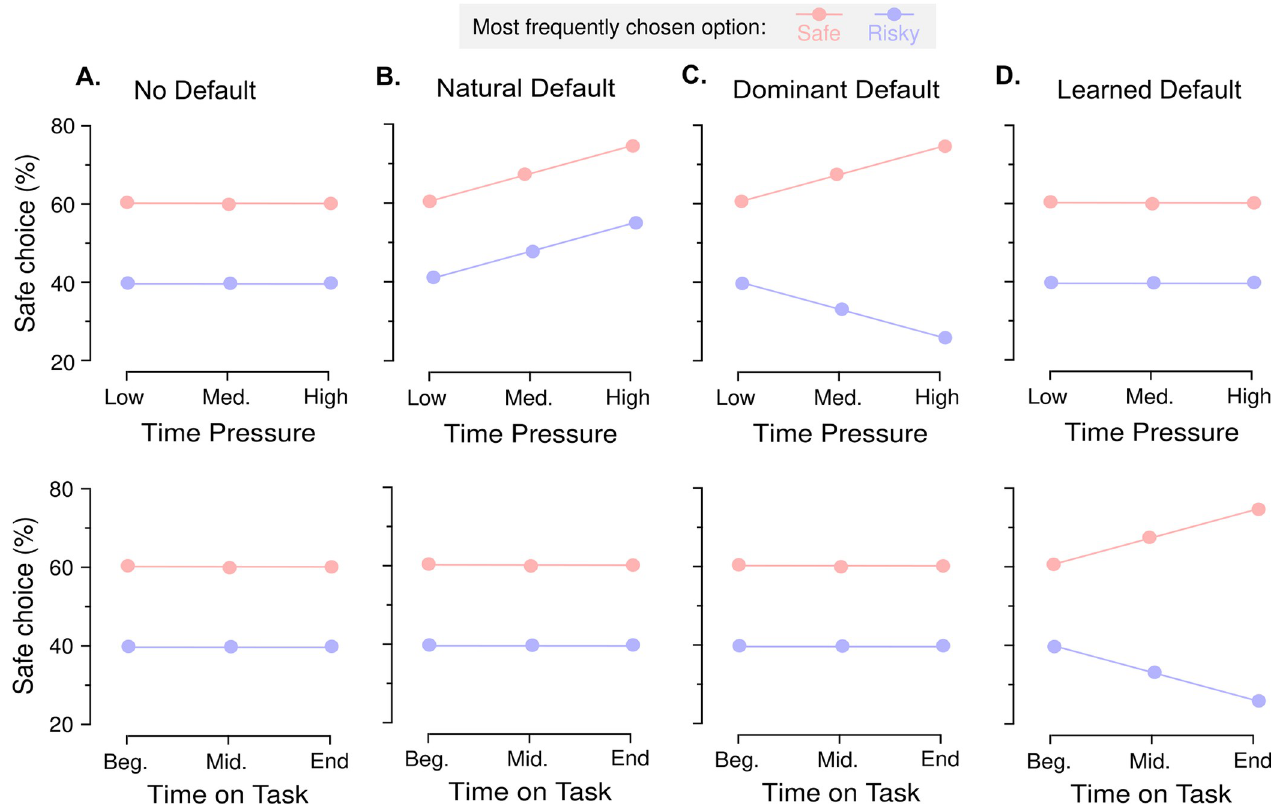
Fig 1. Hypotheses about the underlying causes of default options. Panels depict, under different hypotheses the expected effect of time pressure (top) and time on task (bottom) on the choice pattern of two typical individuals, who predominantly choose the safe (red dots) or the risky (blue dots) option. A. No default option. Neither time pressure nor time on task facilitates the choice of a default option. B. Natural default option. Time pressure may facilitate the choice of natural default options. Under this hypothesis, effects of time pressure do not depend on the manipulation of choice proportion, so individuals’ choices are naturally biased towards an option category (here, the safe lottery), regardless of the most frequently chosen option. C. Dominant default option. Time pressure may, instead, facilitate the choice of dominant default options. Under this hypothesis, effects of time pressure depend on the manipulation of choice proportion, so individuals’ choices are biased towards the most frequently chosen option, by means of simple repetition. D. Learned default option. Time on task may facilitate the choice of learned default options. Effects of time on task also depend on the manipulation of choice proportion, so individuals’ choices are biased towards the most frequently chosen